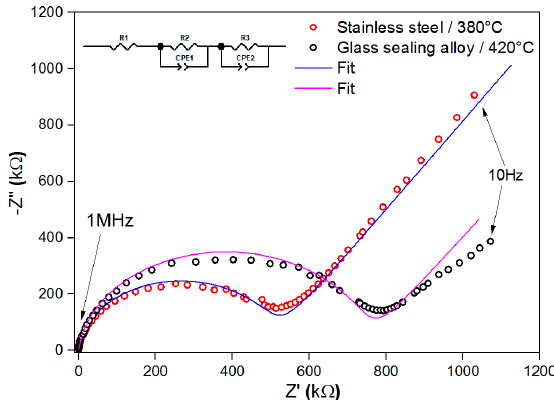
Figure 8. Exemplary Nyquist plots for BaCeO 3 deposited on stainless steel (SST) and glass sealing alloy (GSA) (open symbols) with their fits (lines).